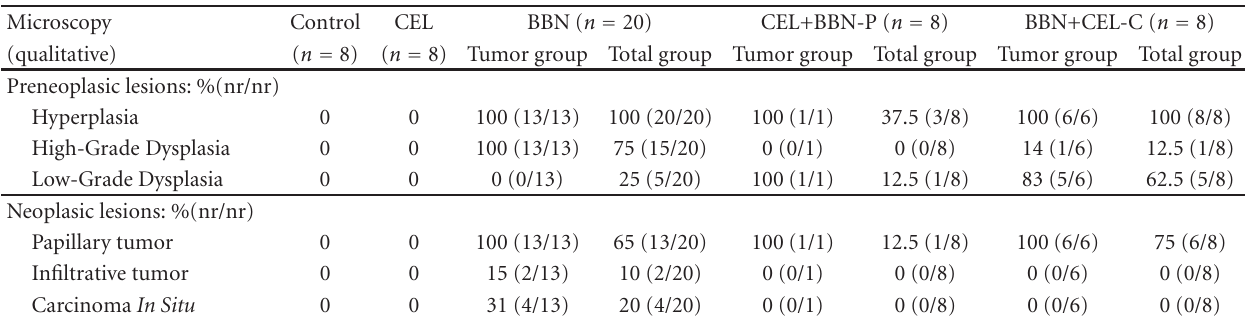
Table 2: The preventive versus curative e ff ect of Celecoxib on bladder cancer: qualitative evaluation of urothelium lesions.